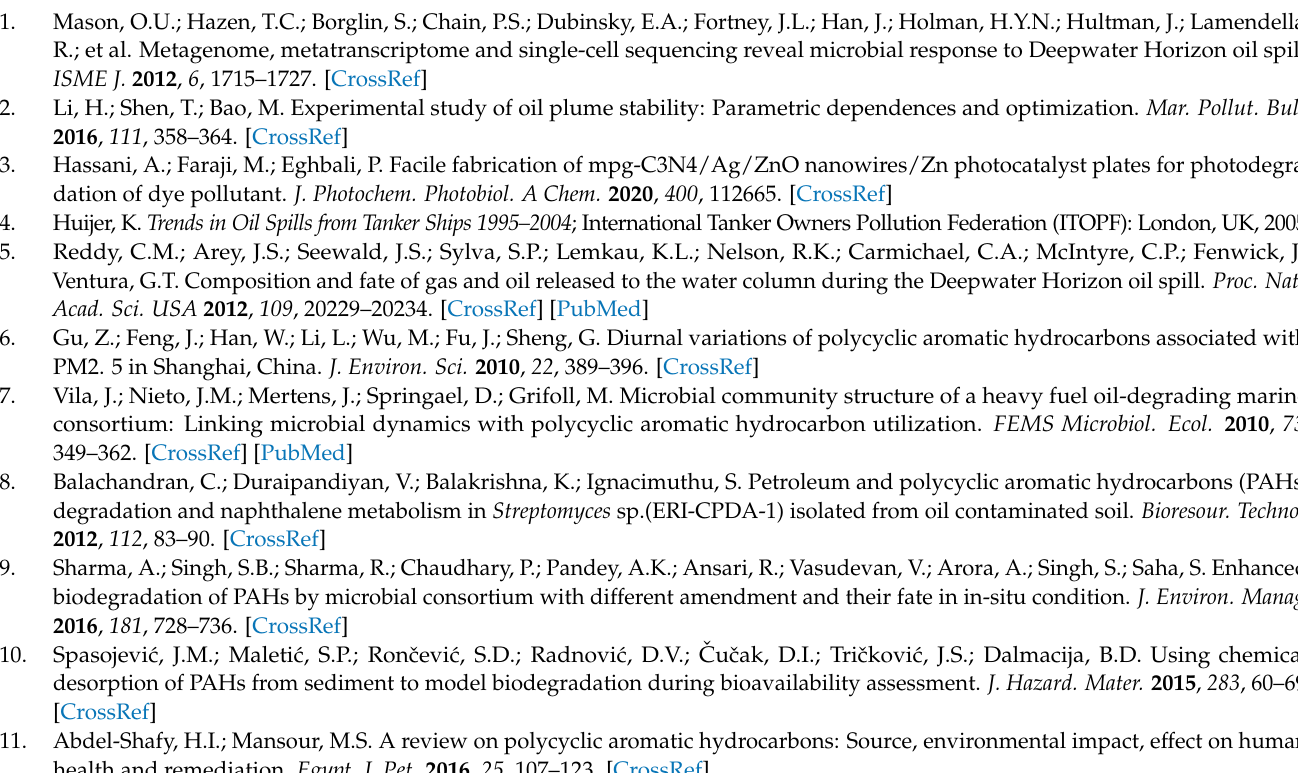
Figure S2: The growth curve of the bacteria; Figure S3: The standard curve of the number of bacteria and the absorbance value; Table S1: Morphological, physiological and biochemical properties of bacteria from oil-contaminated